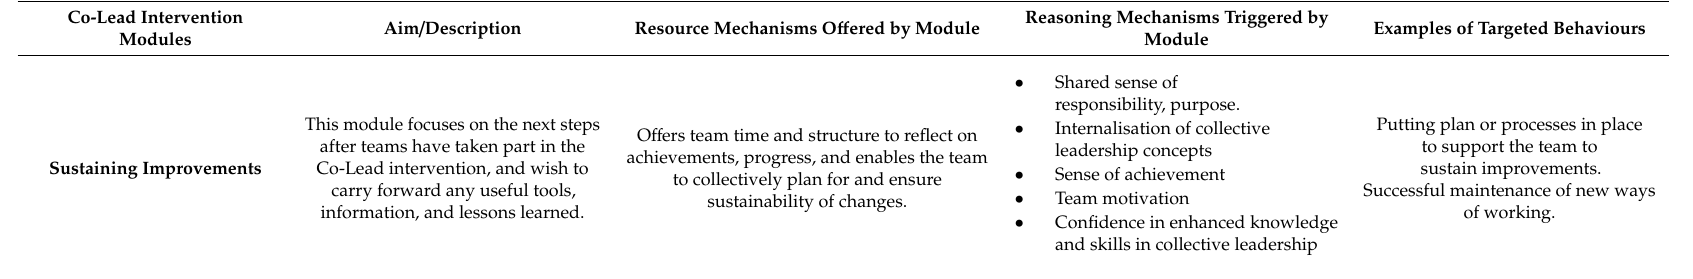
to collectively plan for and ensure sustainability of